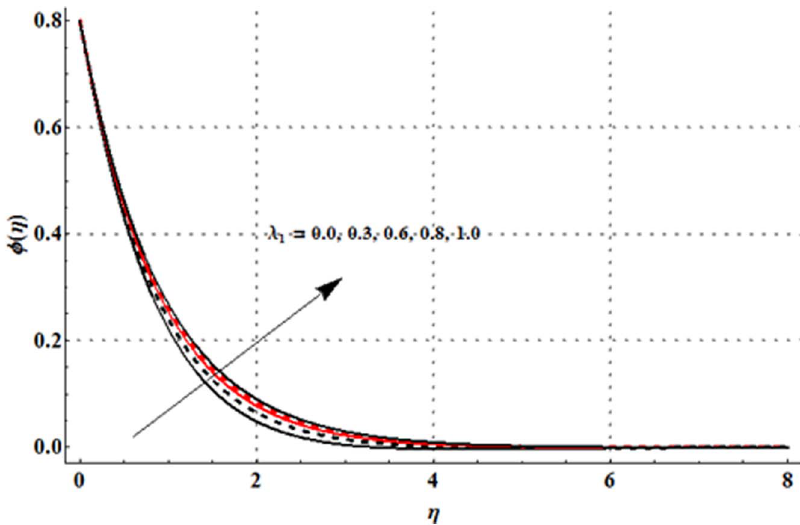
Figure 18. Influence of l 1 on the concentration profile w ( g ) when M ~ 0 : 6, b ~ 0 : 4 ~ Rd , l ~ 0 : 3 ~ N , Pr ~ 1 : 2, S ~ 0 : 2 ~ S (cid:2) and Sc ~ 1 : 0 :